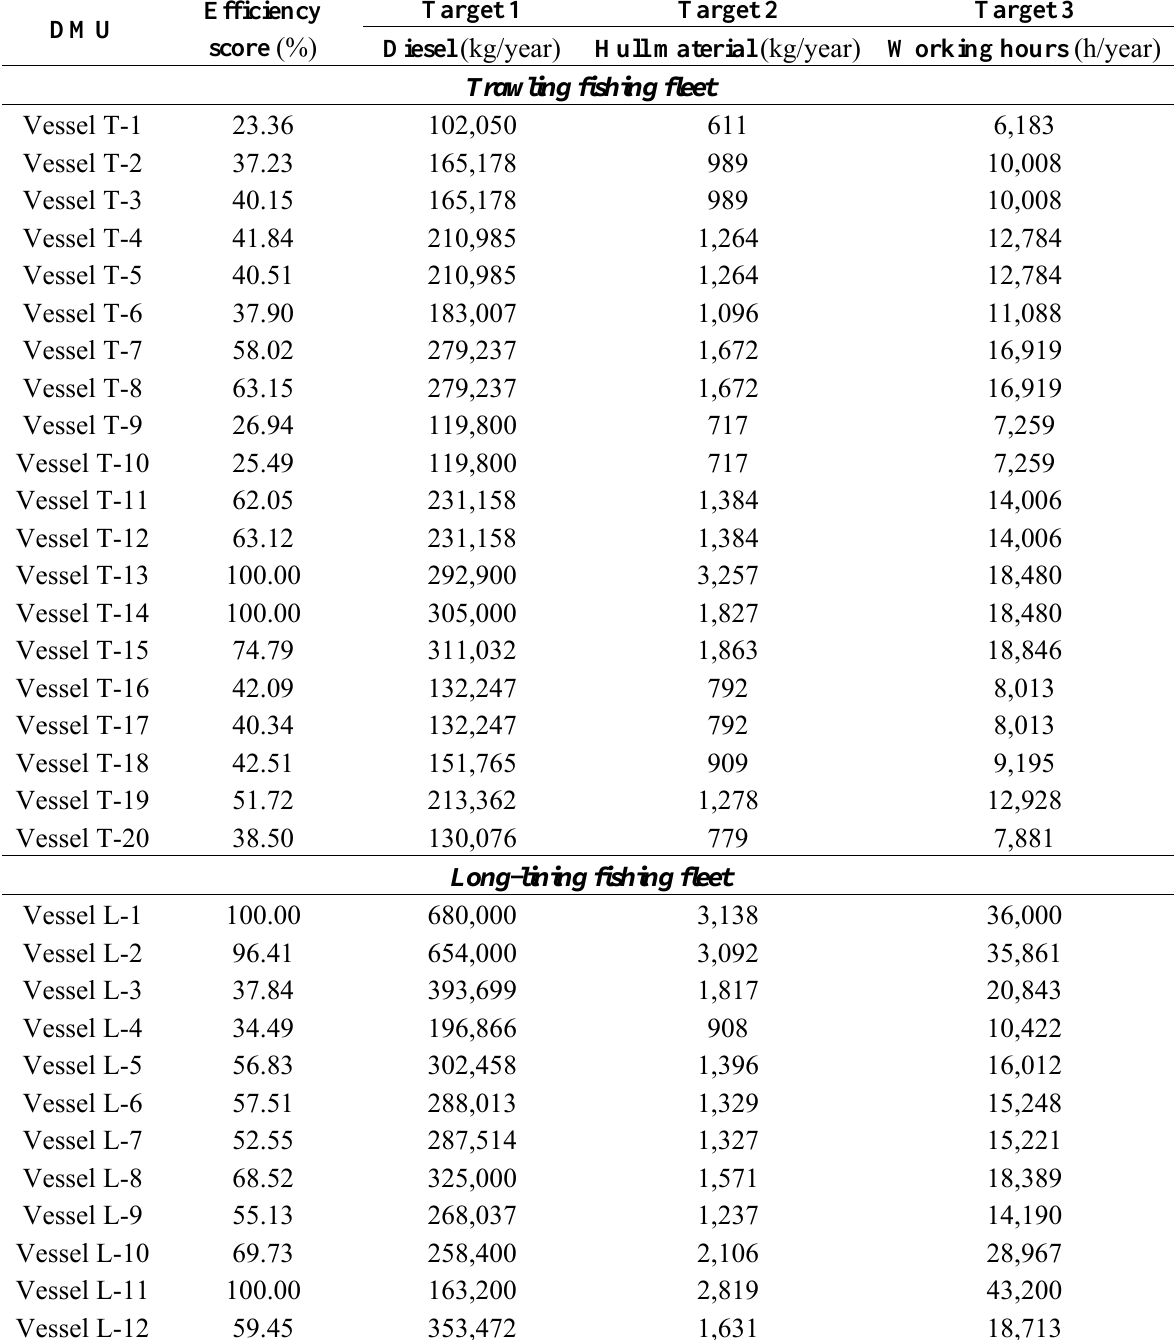
Table 3. Efficiency scores and target values for the illustrative case studies using the number of hours as an